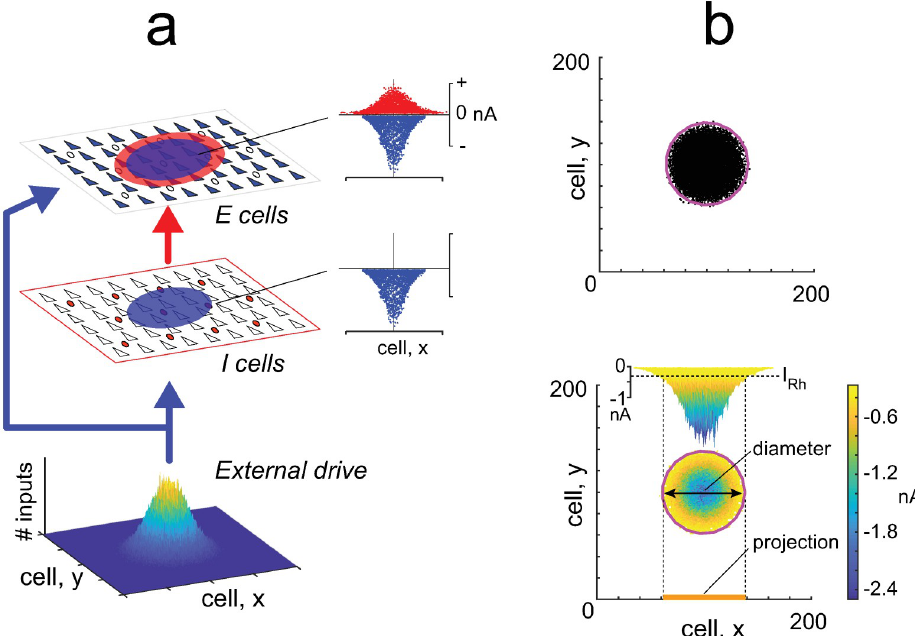
Fig 5. Simulations with spiking neurons. a , Network consists of excitatory and inhibitory neuron populations. An external drive evokes excitatory inputs in both populations (blue disks) and inhibitory inputs to the E cells (red disk). insets , profiles of excitatory (blue) and inhibitory (red) currents evoked in the E and I populations. b, bottom , synaptic field evoked in the network during a stimulus. The spatial extent of the synaptic field is quantified either by the diameter of a circle fitted to its outermost points (magenta) or by the length of its projection to the tonotopic axis (orange bar). inset , profile of net synaptic current generated in the E cell population. The perimeter of the synaptic field encompasses cells whose net synaptic current input exceeded rheobase ( I Rh ). top , activated area contains cells that fired action potentials